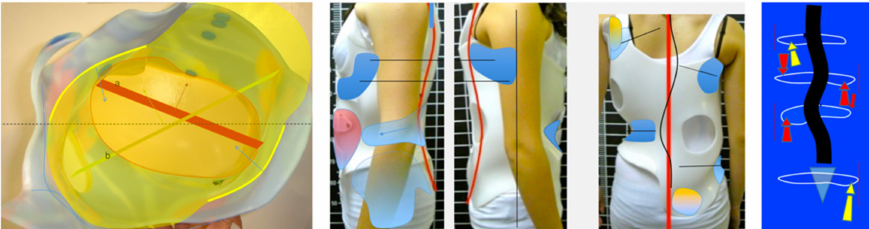
Figure 1. The brace design when treating a double structural scoliosis (Rigo B Type). Two mech- anisms for regional derotation are applied, one at the main thoracic region and another at the lumbar/thoracolumbar region (red arrows). These two mechanisms for regional derotation work in combination with two counter-rotation forces (yellow arrows). Contact areas are provided, later- ally, ventrally and dorsally, to guide the frontal as well as the sagittal plane alignment and balance. (The figures describe the brace design showing an adolescent. The brace design in EOS follows the same principles).